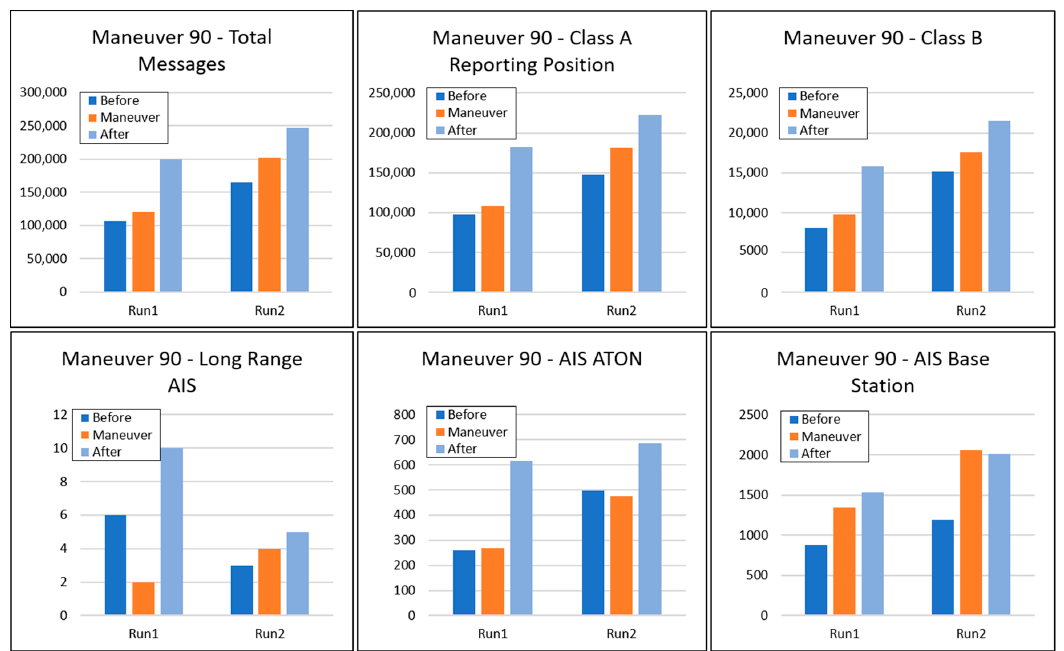
Figure 9. Comparison of AIS message acquired under the 90°-maneuvered flight configuration.